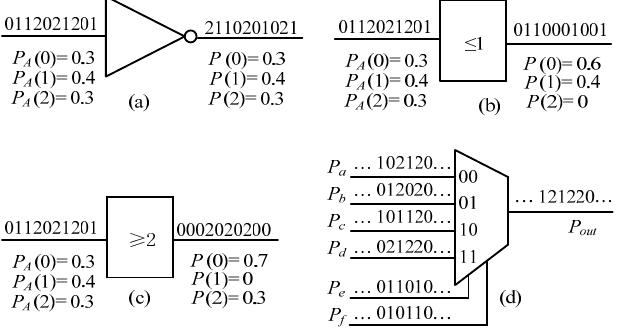
Figure 2. Stochastic logic gates: ( a ) a ternary-valued inverter; ( b ) an MVS logic; ( c ) an MVEL logic; ( d ) a 4-to-1 multiplexer.